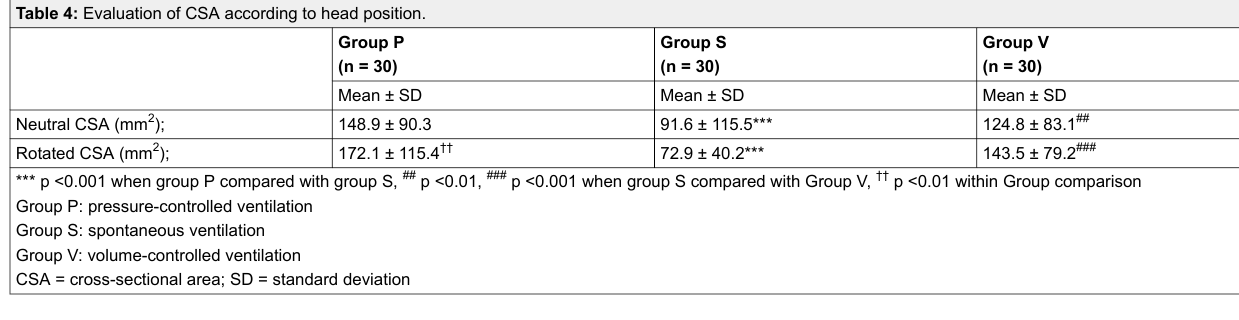
Table 4: Evaluation of CSA according to head position.